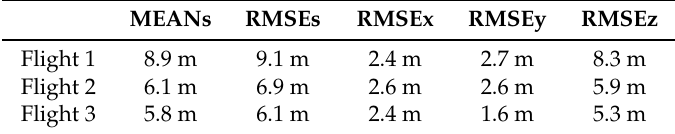
Table 5. Differences in image position between the SfM and GPS positions.